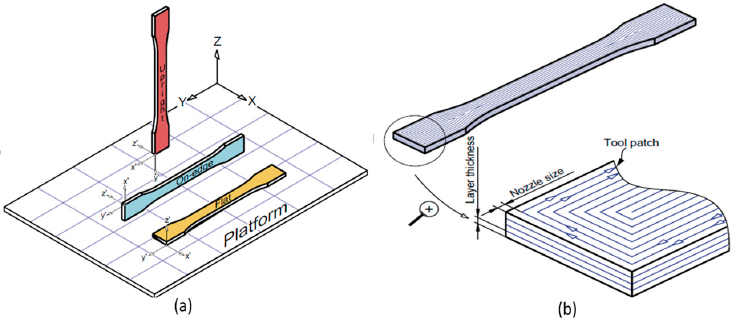
Figure 4. Process parameters: ( a ) build orientation; and ( b ) raster orientation. Adapted from [62], with permission from © 2017 Elsevier .